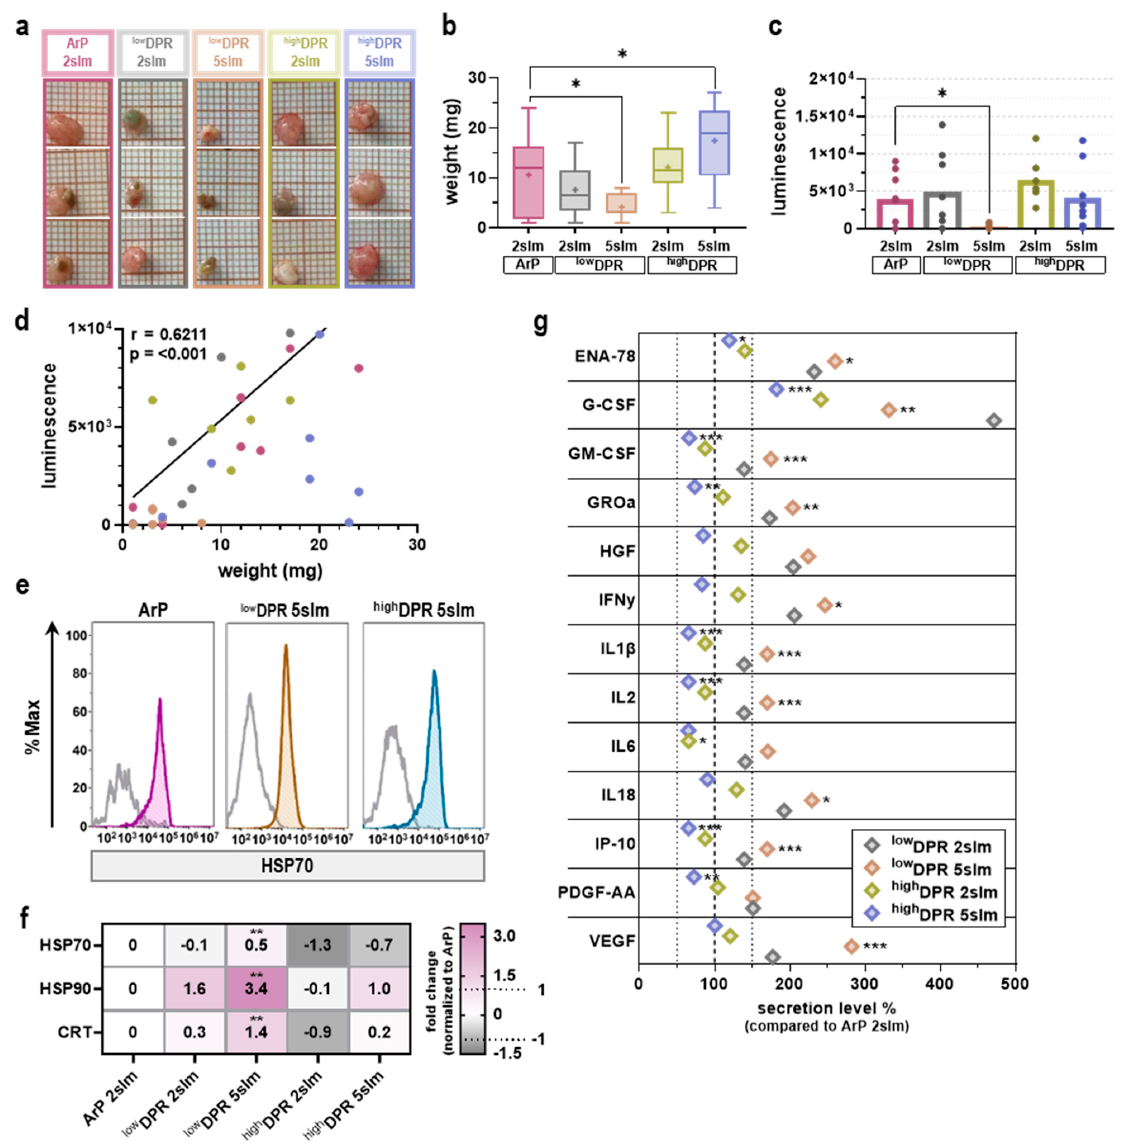
Figure 5. Anti-tumor activity of MoNoS-complemented gas plasma treatment outperforms typical kINPen treatment at high gas flow rates. ( a ) representative images of in ovo grown